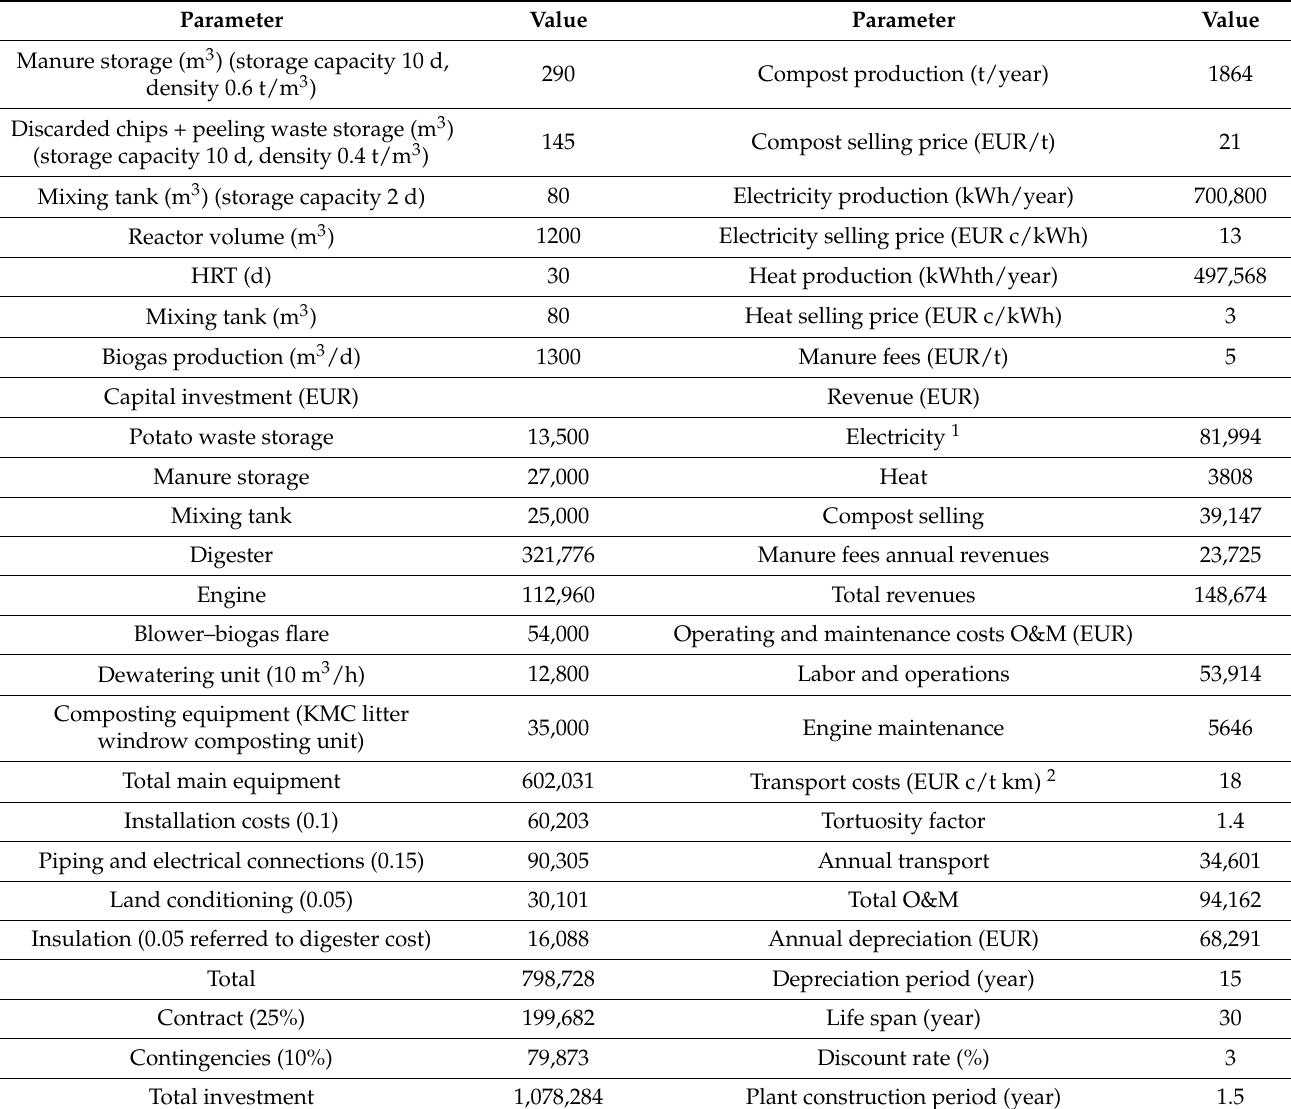
Table 4. Techno-economic parameters of a co-digestion plant for treating a mixture of sheep manure and potato processing waste. Parameter Value Parameter